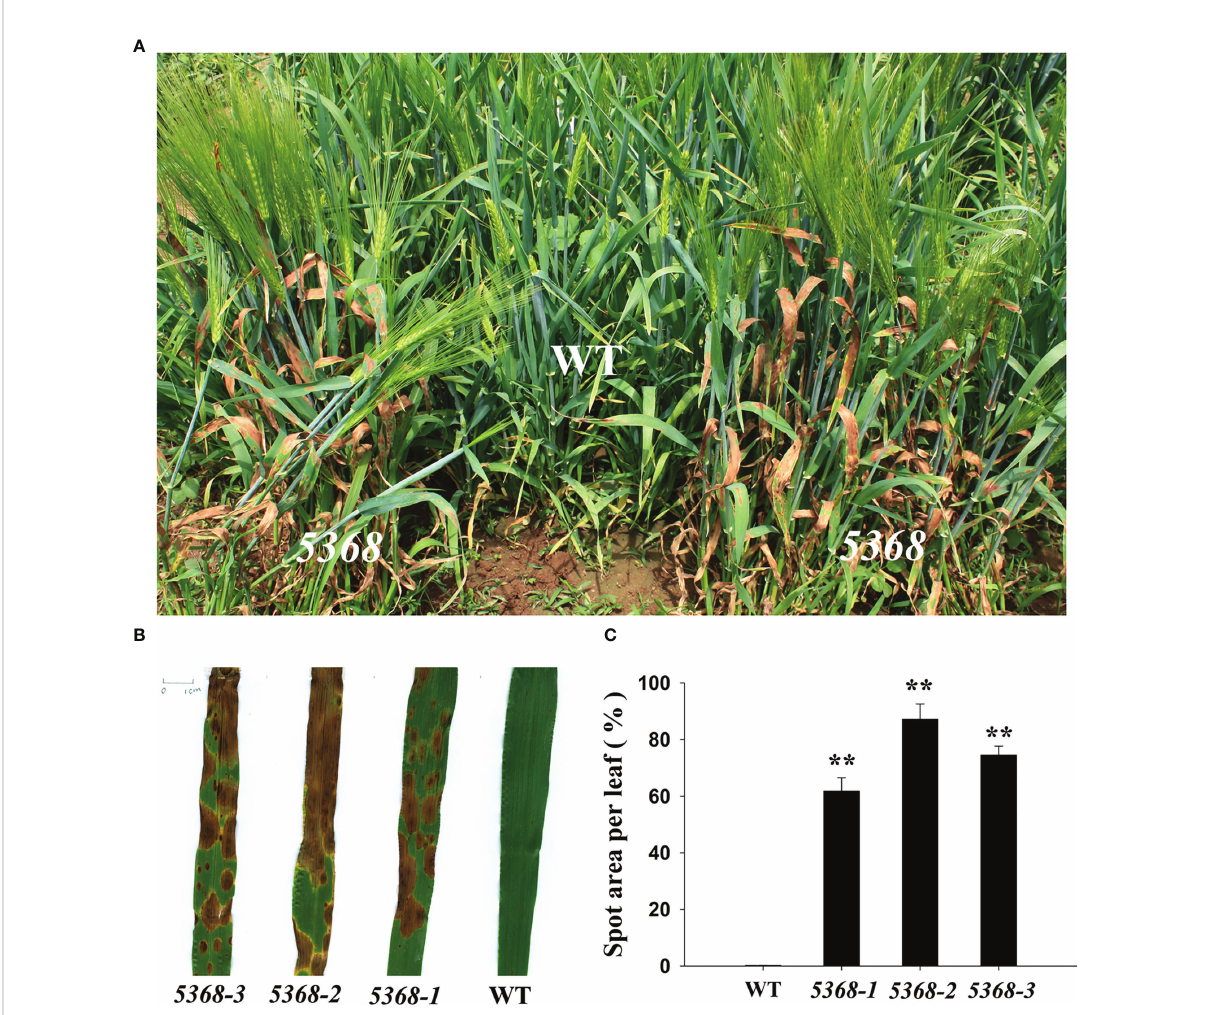
FIGURE 1 Phenotype differences between WT and LMM 5386 lines in the fi eld. (A) Phenotype in the fi eld; (B) leaf brown spots; (C) spot area per leaf. Values are means ± SD based on 30 replicates. Error bars indicate standard deviations. **P <